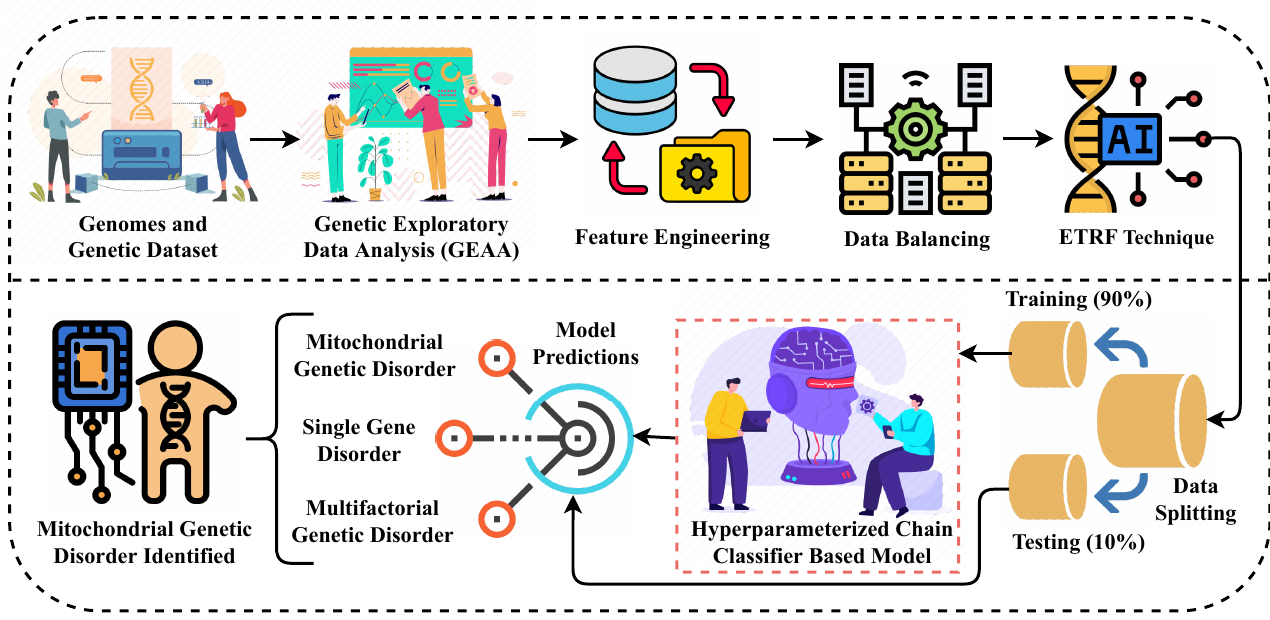
Figure 1. The methodological analysis of our proposed research approach for predicting the genetic disorder and types of